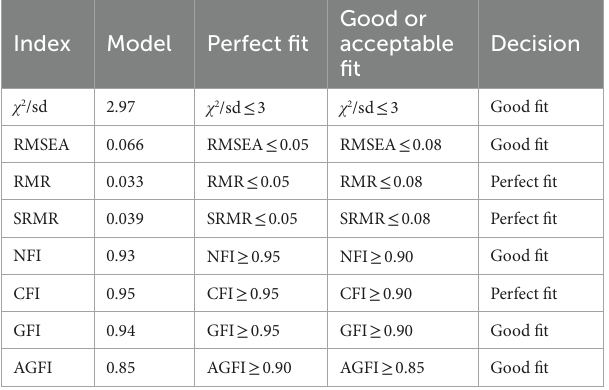
TABLE 4 Evaluation of the fit indices for model testing.